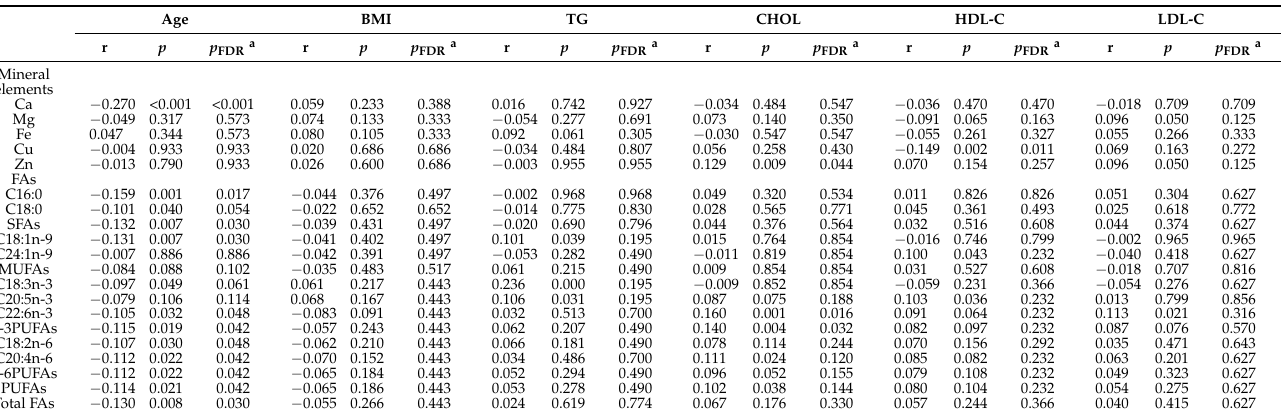
Table 2. Correlation of mineral element and erythrocyte FAs with age, BMI, and plasma lipid parameters in children.